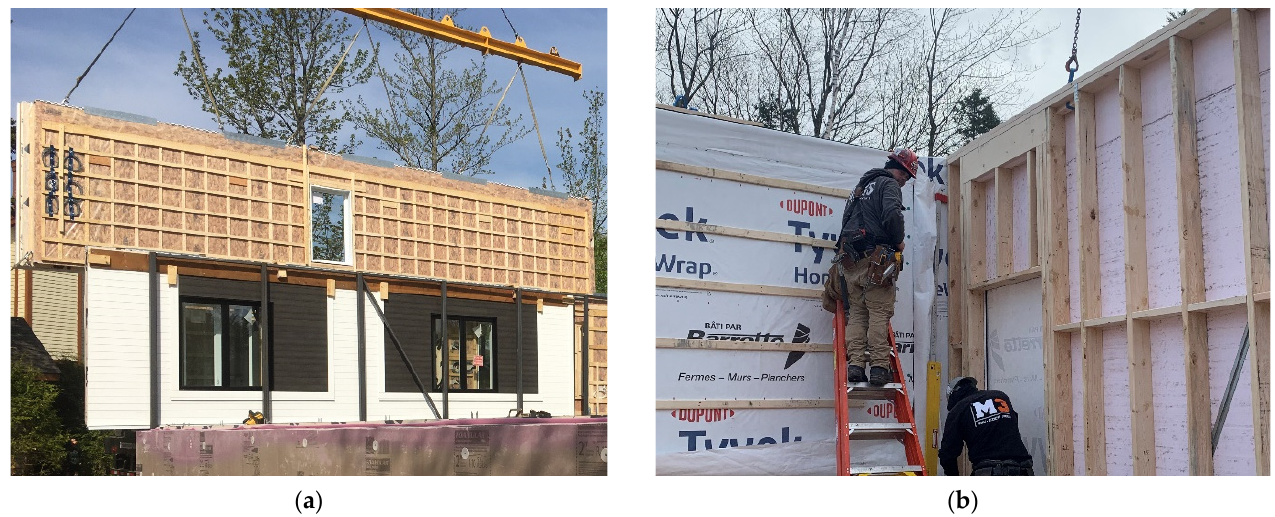
Figure 15. Composition of the prefabricated walls of House A during lifting ( a ) and House B ( b ).